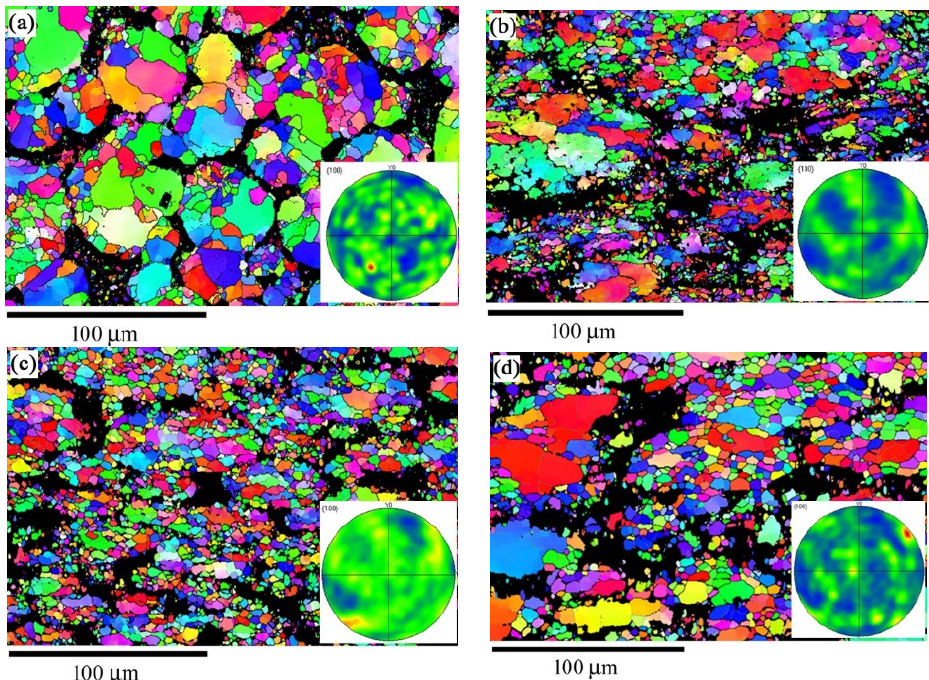
Figure 8. The initial state ( a ), the state after deformation at 300 ( b ), 400 ( c ), and 500 °C ( d ) for the V95\10% SiC metal matrix composite.